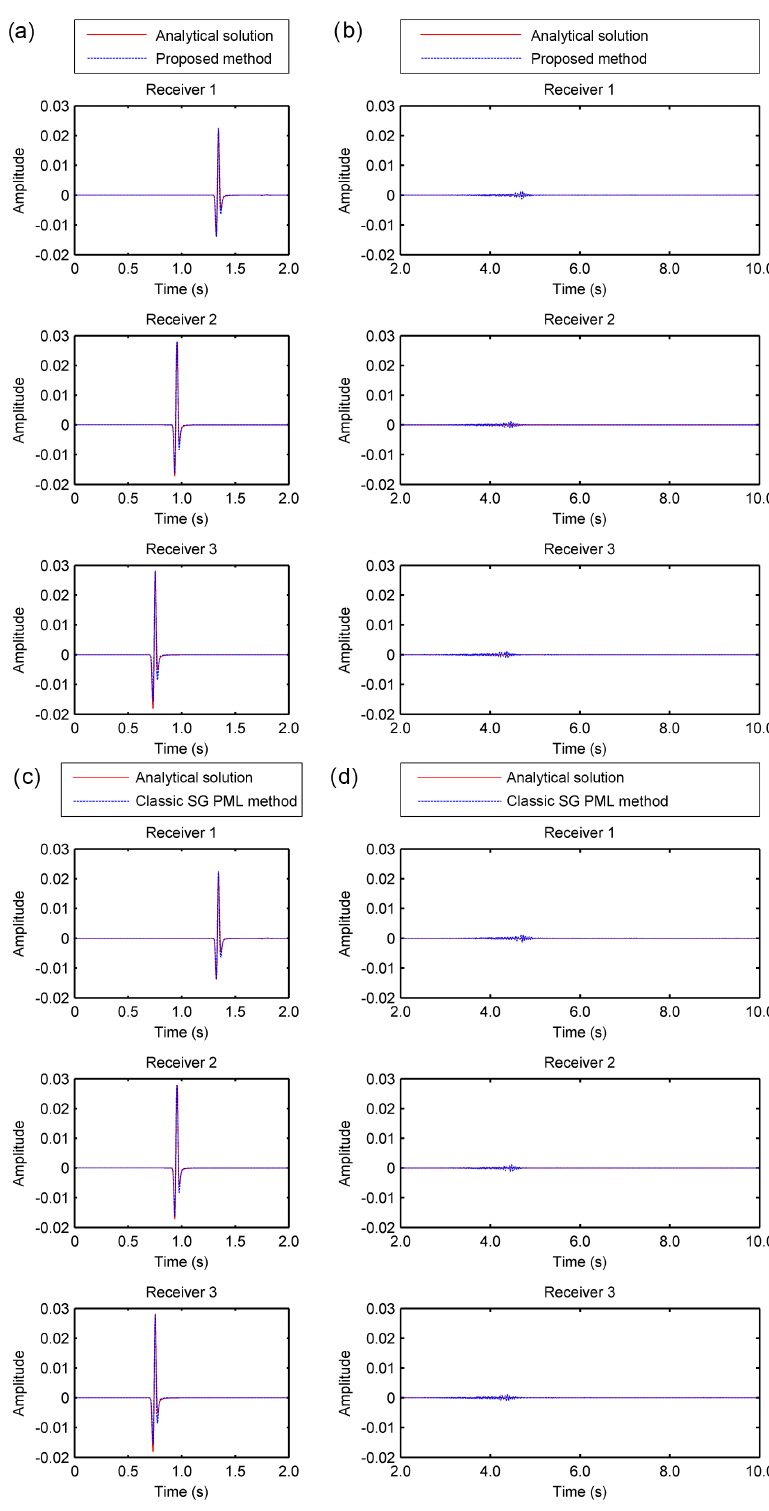
Figure 9. Comparison of the analytical solutions of the proposed (10th-order CG scheme) (red solid line) and the classic SG PML methods (10th-order SG scheme) (blue dotted line) at different receivers, d = 10m. (a) Proposed method at receivers 1, 2, and 3 during the first 2s; (b) proposed method at receivers 1, 2, and 3 after 2s; (c) classic SG PML method at receivers 1, 2, and 3 during the first 2s; (d) classic SG PML method at receivers 1, 2, and 3 after